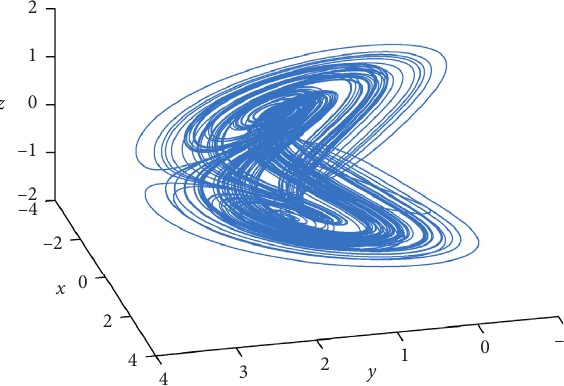
Figure 19: Dynamic behavior of fractional financial chaotic model with α � 0 . 95.